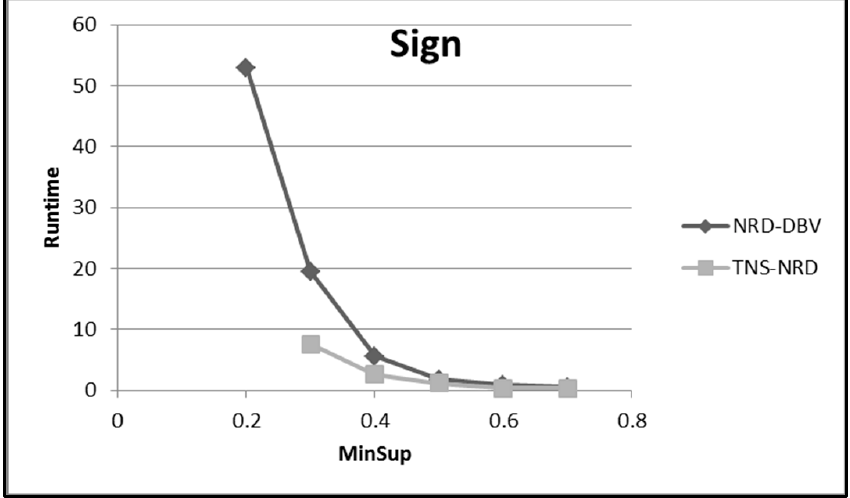
Figure 17. Comparison of the runtime of the TNS with the NRD-DBV for (Sign) dataset.